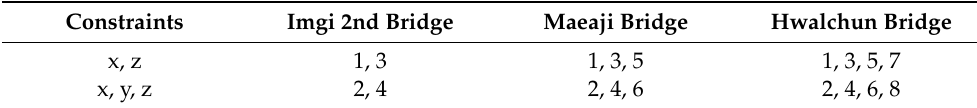
Figure 3. Measurement positions and groups on the target bridges: ( a ) Imgi 2nd Bridge; ( b ) Maeaji Bridge; ( c ) Hwalchun Bridge. Table 2. Boundary conditions of the target bridges.